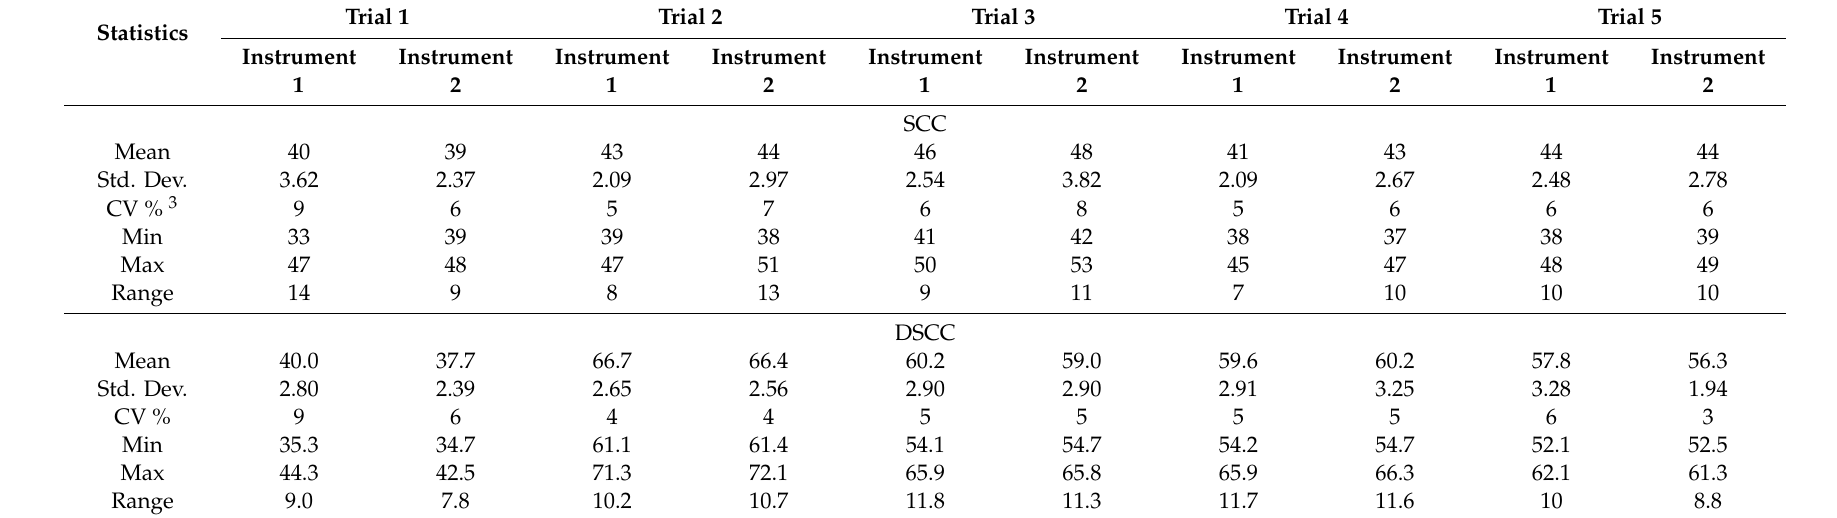
Table 1. Results of repeatability trials for DSCC 1 and SCC 2 in milk samples with ≤ 50,000 cells /